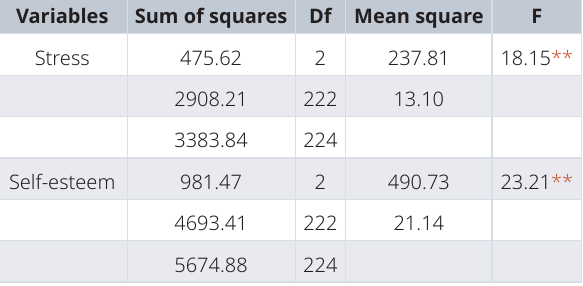
Table 4. Approximate F for the pre- and post-phases of stress and self-esteem. Variables